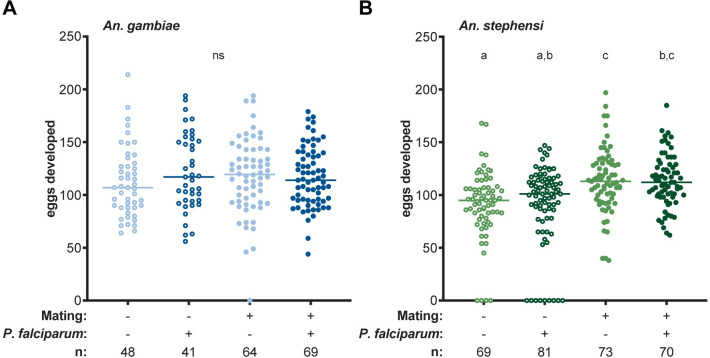
P. falciparum infection does not affect the fecundity of An. gambiae and An. stephensi females.P. falciparum infection does not affect the number of eggs developed by virgin and mated (A)
An. gambiae females (infection: likelihood ratio test (LRT) X21 = 0.76, p = 0.38; mating*infection: LRT X21 = 3.1, p = 0.08) or (B)
An. stephensi females (infection: LRT X21 = 0.007, p = 0.94; mating*infection: LRT X21 = 0.99, p = 0.32). In An. stephensi, mating increased the likelihood of egg development (LRT X21 = 16.26, p < 0.001) and the number of eggs developed (mating: LRT X21 = 20.22, p < 0.001). The data from this graph are from three replicates for each Anopheles species. Pairwise comparisons (letters) are computed via estimated marginal means. Lines represent medians, and n represents sample size. Open circles represent virgin females, closed circles represent mated females, and light and dark colors correspond to uninfected and infected females, respectively. ns = not statistically significant.